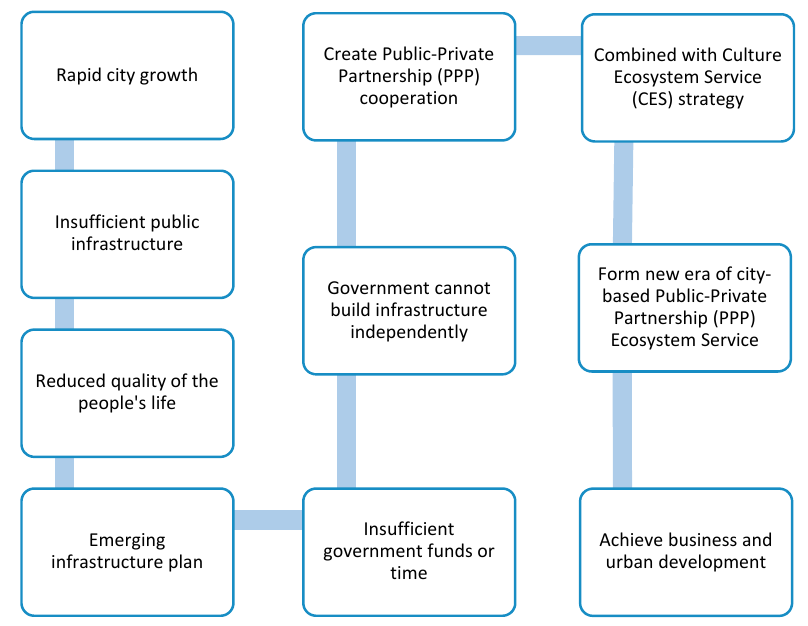
Figure 1. Concept of City-based PPP combined with Culture Ecosystem Service.